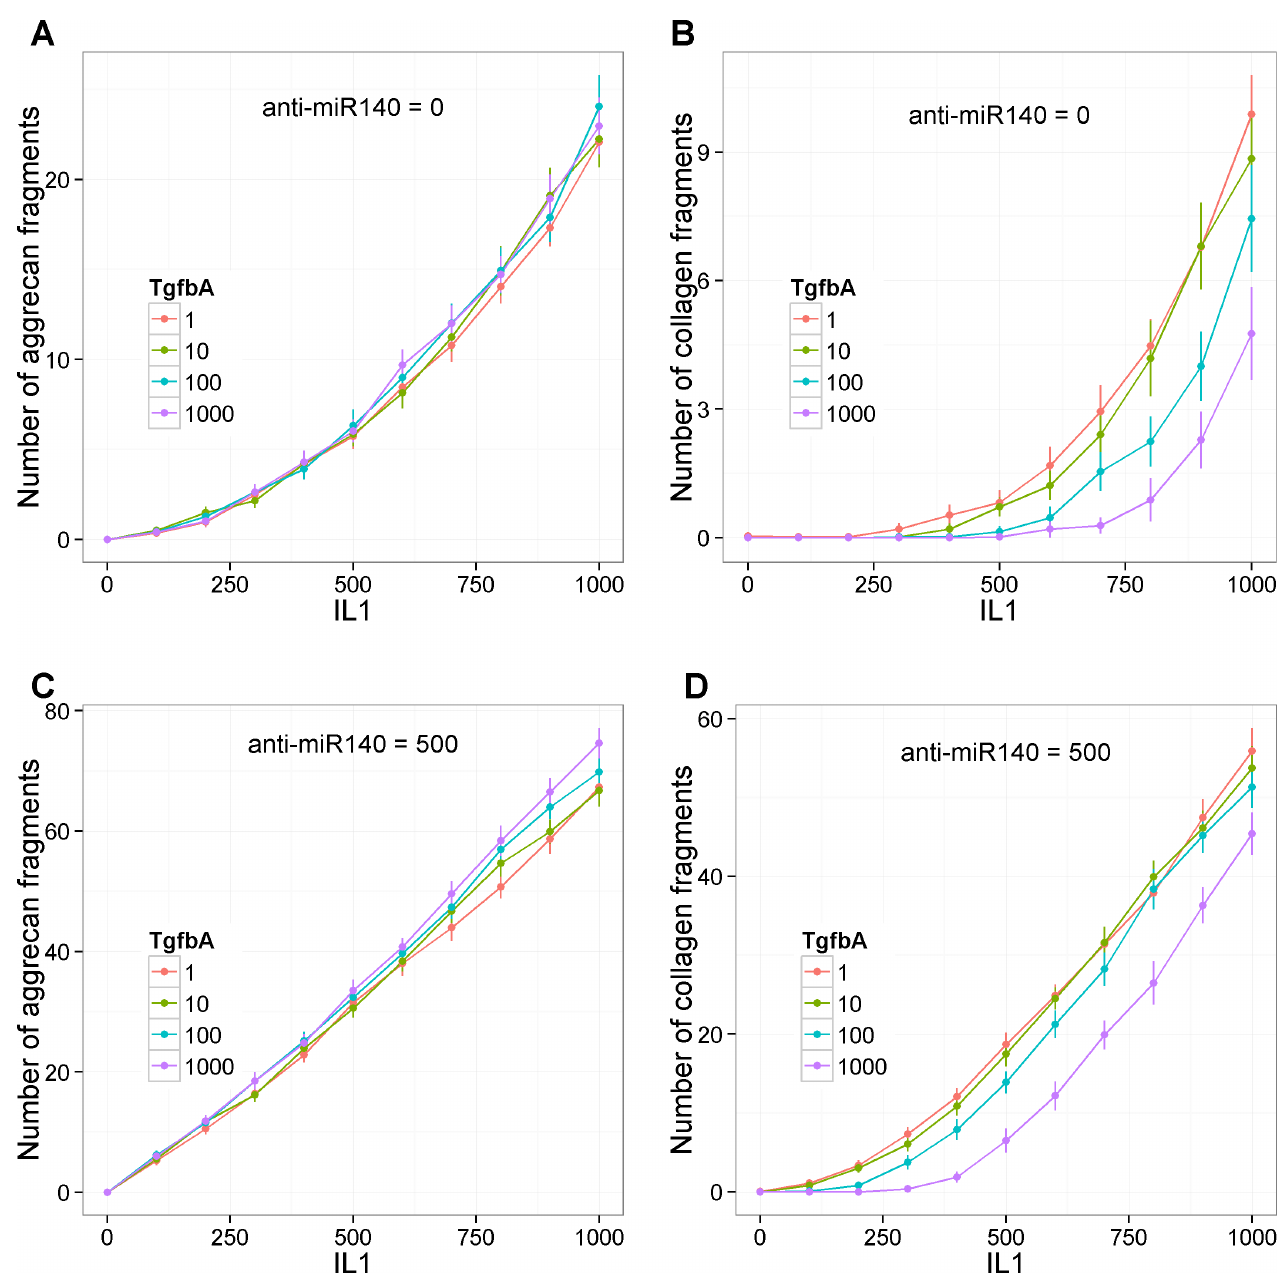
Fig 9. Integrated model: Combined effect of IL-1, TGF- β and miR-140on cartilage degradation. Model output showingeffect of varyingthe initial amounts of IL-1 (0–1000,10 intervals) and TGF- β (1–1000,3 intervals, log scale) simultaneously on levels of aggrecan fragments ( A , C )or collagen2fragments( B , D ). A - B , no miR-140inhibition(anti-miR140 = 0), C - D , miR-140inhibition(anti-miR-140 = 500). Curves show mean of 100 stochastic simulations, error bars indicate95% confidenceinterval of the mean.